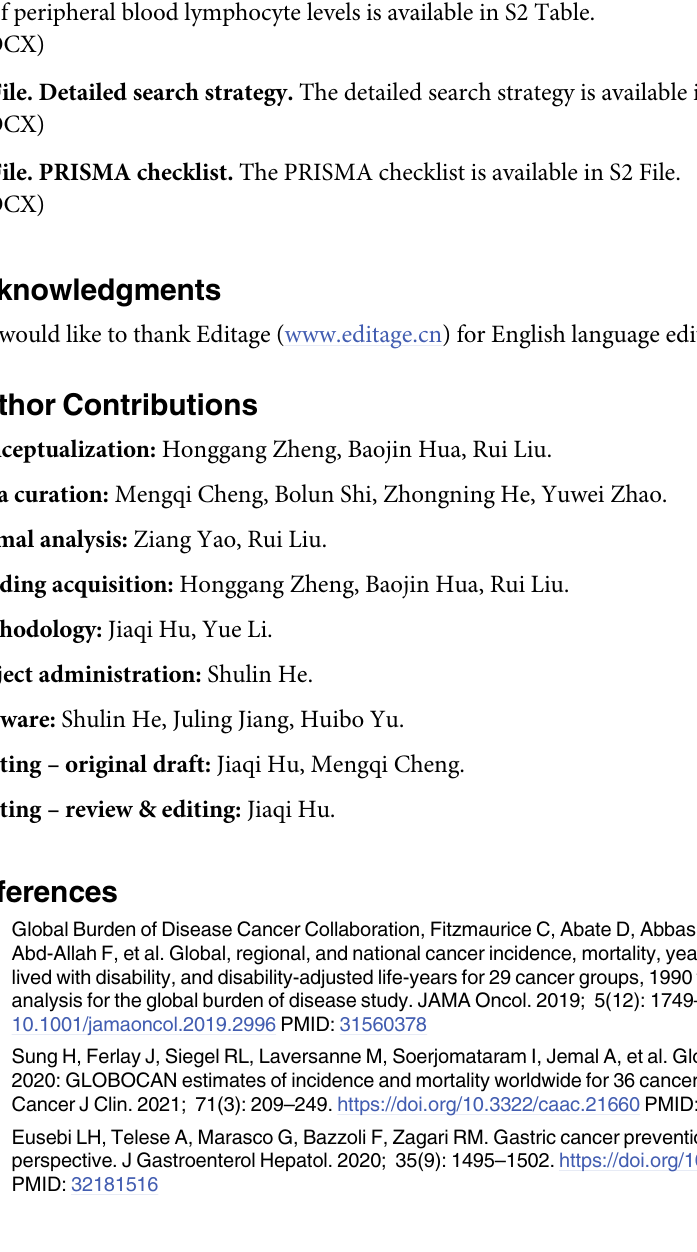
S1 Table. Subgroup analysis of the QoL using dichotomous data. The subgroup analysis of the QoL is available in S1 Table. S2 Table. Subgroup analysis of the peripheral blood lymphocyte levels. The subgroup analy- sis of peripheral blood lymphocyte levels is available in S2